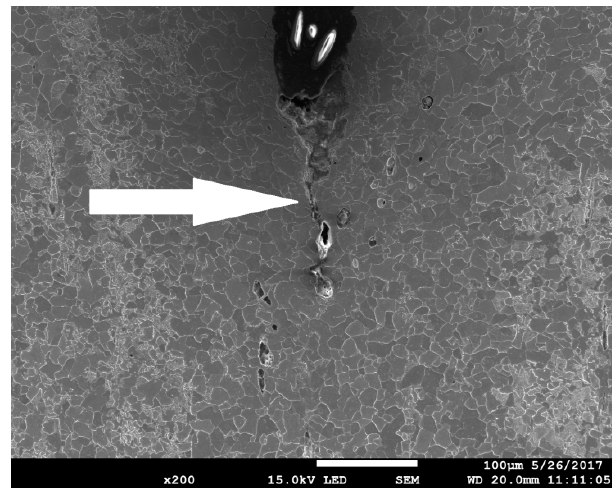
Figure 12. The image of the surface in front of the crack located at the specimen center perpendicular to the crack front, material N, temperature +20 °C. Arrow indicates the crack extension by voids mechanism.